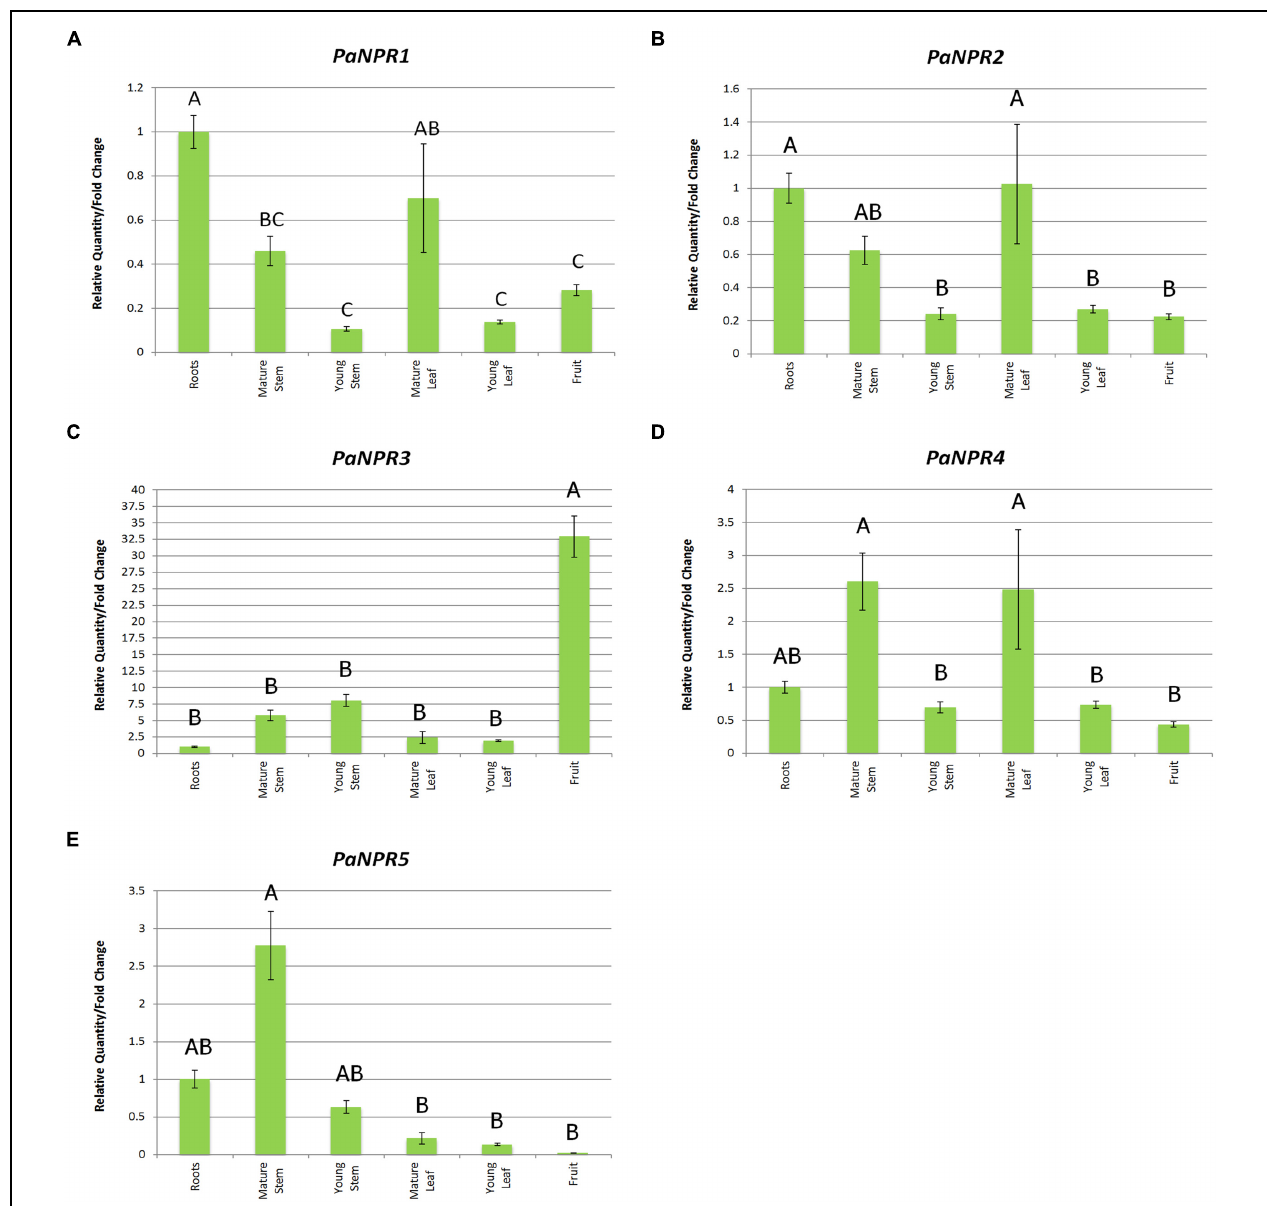
FIGURE 4 | Expression of PaNPR1 -like genes in various tissues. Normalized relative quantities (fold change) for (A) PaNPR1 , (B) PaNPR2 , (C) PaNPR3 , (D) PaNPR4 , and (E) PaNPR5 were calculated using the method described by Pfaffl (2001). The response is indicated by vertical bars across six tissues; feeder roots, mature green stems, mature green